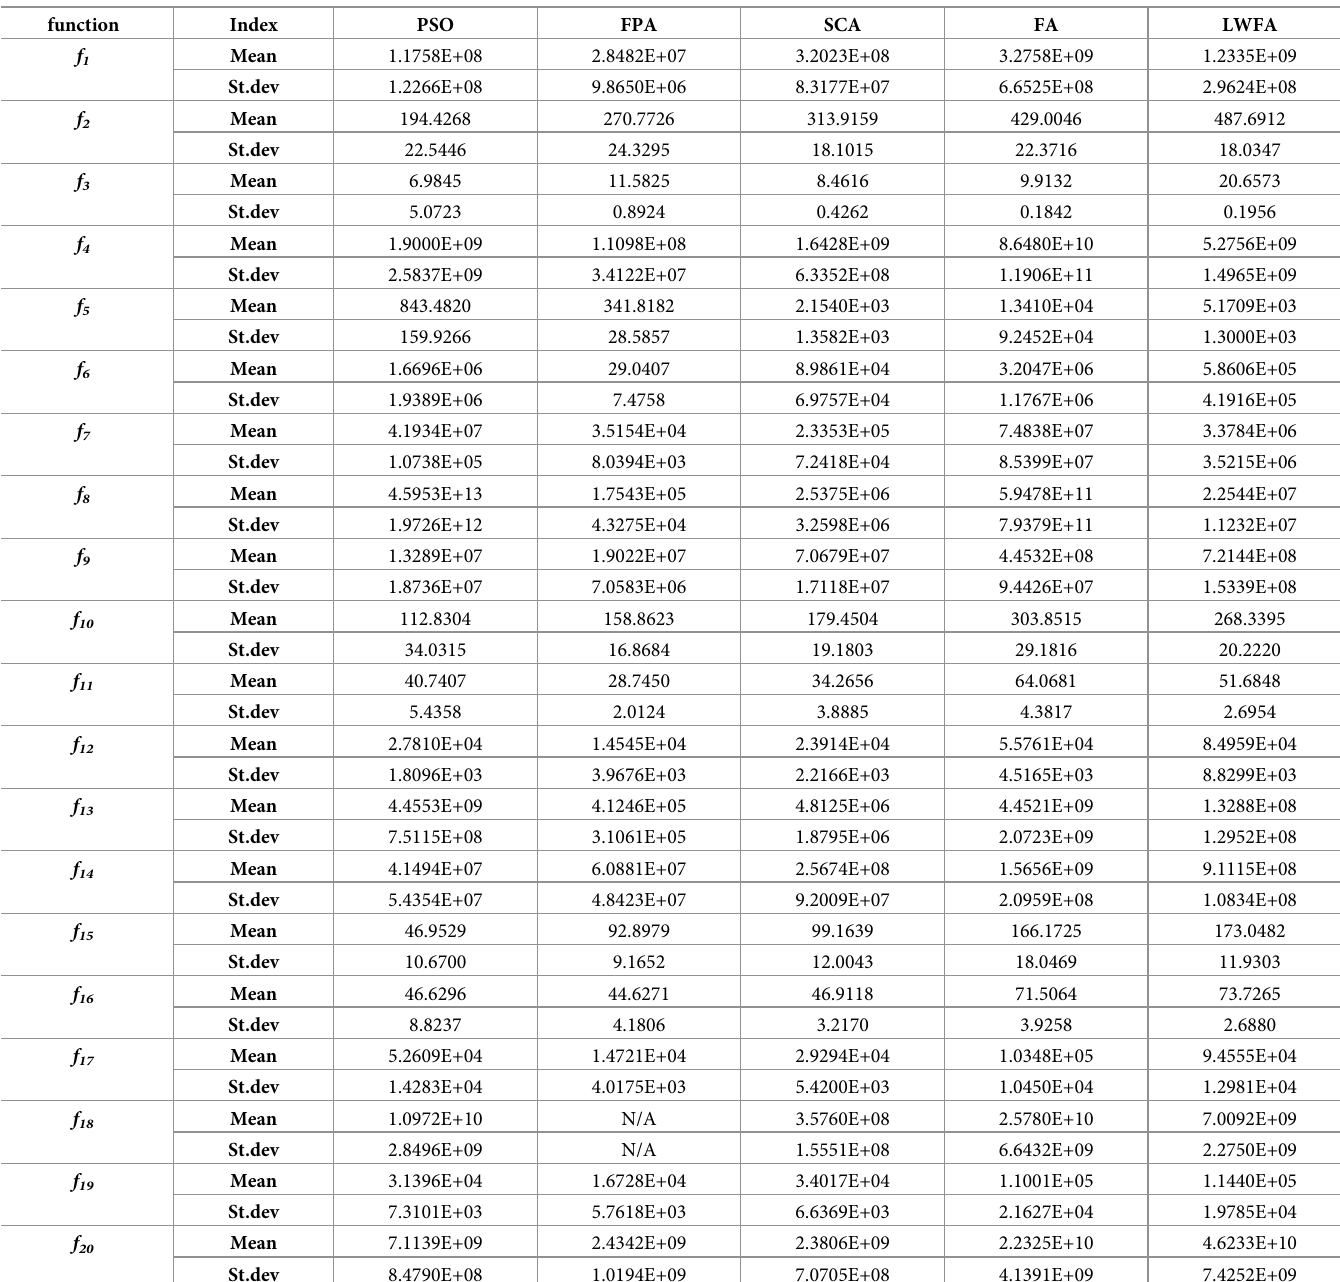
Table 8. The result of CEC2010 standard functions for different algorithms (D =